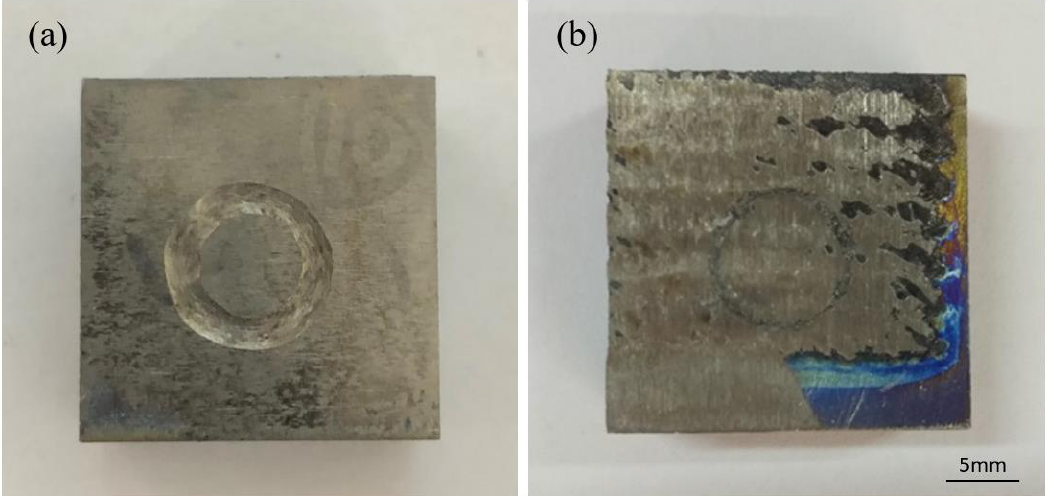
Figure 9. Surface morphologies of the substrate ( a ) and the coating ( b ) after the wear test.